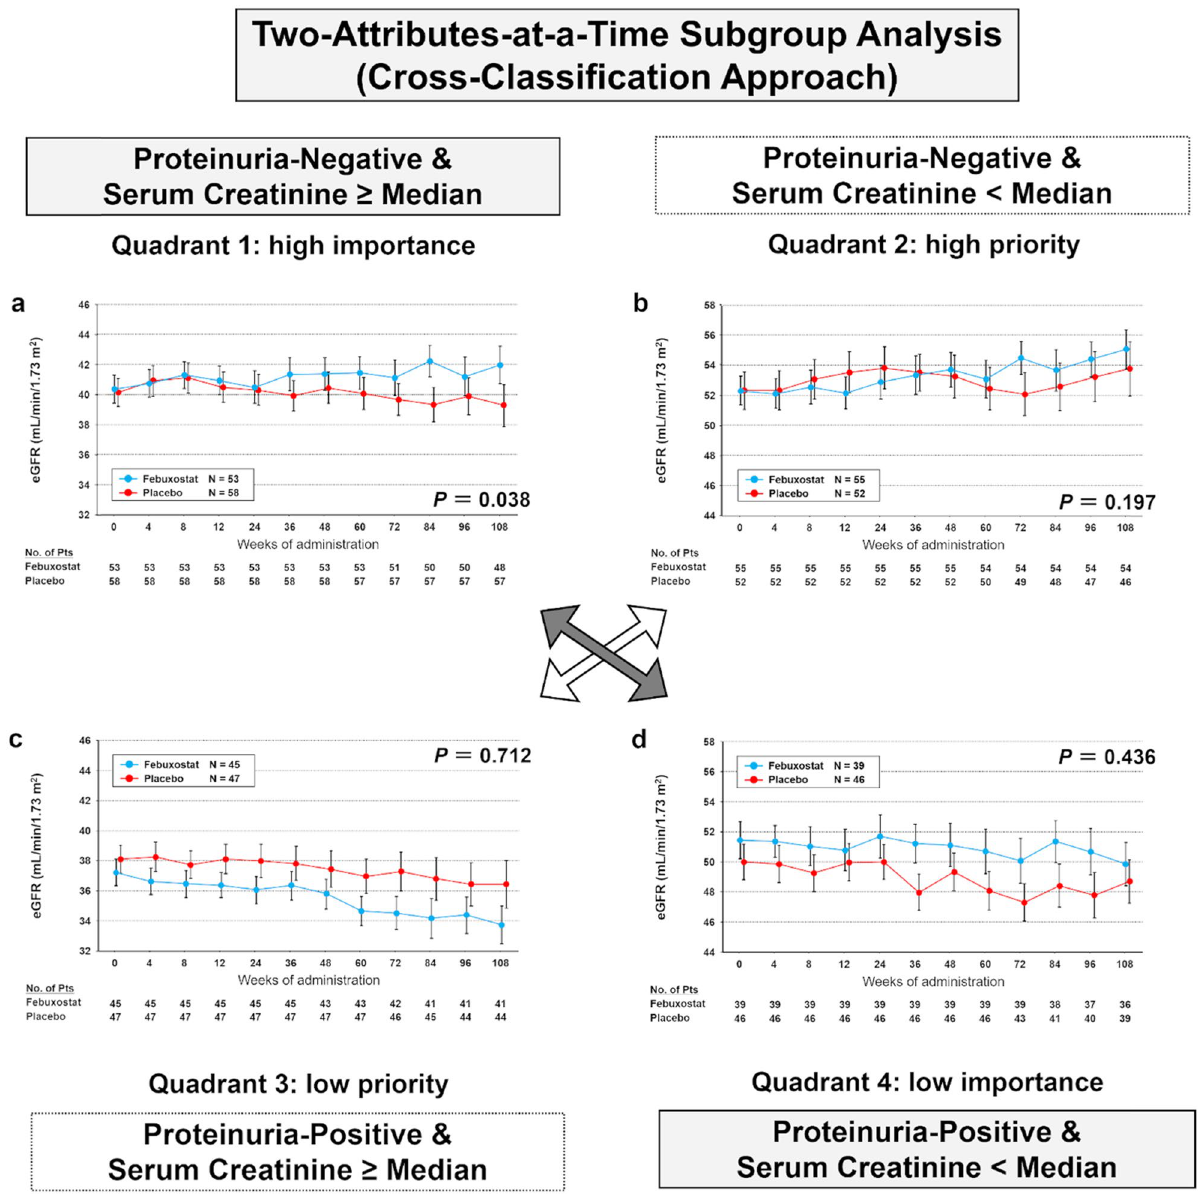
Figure 4. Time-course changes in estimated glomerular filtration rates (eGFRs) from week 0 through week 108 of treatment in subcohorts according to cross-classification. ( a ) Quadrant 1: without proteinuria and a serum creatinine level ≥ median. ( b ) Quadrant 2: without proteinuria and a serum creatinine level < median. ( c ) Quadrant 3: with proteinuria and a serum creatinine level ≥ median. ( d ) Quadrant 4: with proteinuria and a serum creatinine level < median. The mean eGFR in the two groups is shown at different timepoints during the trial. Error bars indicate the standard error. The mean eGFR is shown for participants with available levels at each timepoint. P -values were obtained by a test of the trend profile using a mixed model. Similar to Fig. 2, quadrants 1 and 4 can be used to discriminate the importance of the absence of proteinuria and a serum creatinine level < median for the efficacy of febuxostat in patients with chronic kidney disease. As the trend profile in the time-course changes in the eGFRs in quadrant 1 was significant for the efficacy of febuxostat, despite the fact that the serum creatinine level was ≥ median, the absence of proteinuria is a more important attribute compared to the serum creatinine level being < median. Accordingly, the absence of proteinuria is an attribute affecting the efficacy of febuxostat in patients with chronic kidney